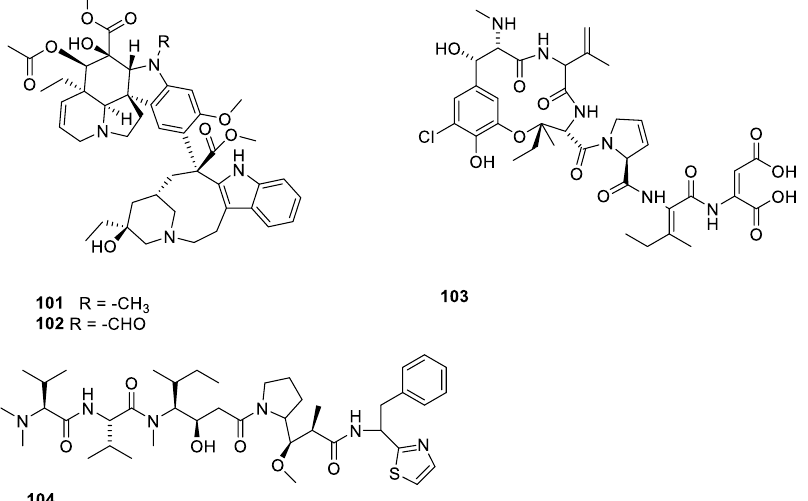
Figure 27. Microtubule-destabilizing agents with affinity for the vinca domain: Vinblastin ( 101 ), vincristine ( 102 ), phomopsin A ( 103 ), dolastatin 10 ( 104 ) [21,92]. Dolastatin 10 ( 103 ) was isolated from and Indian sea hare Dolabella auricularia . The